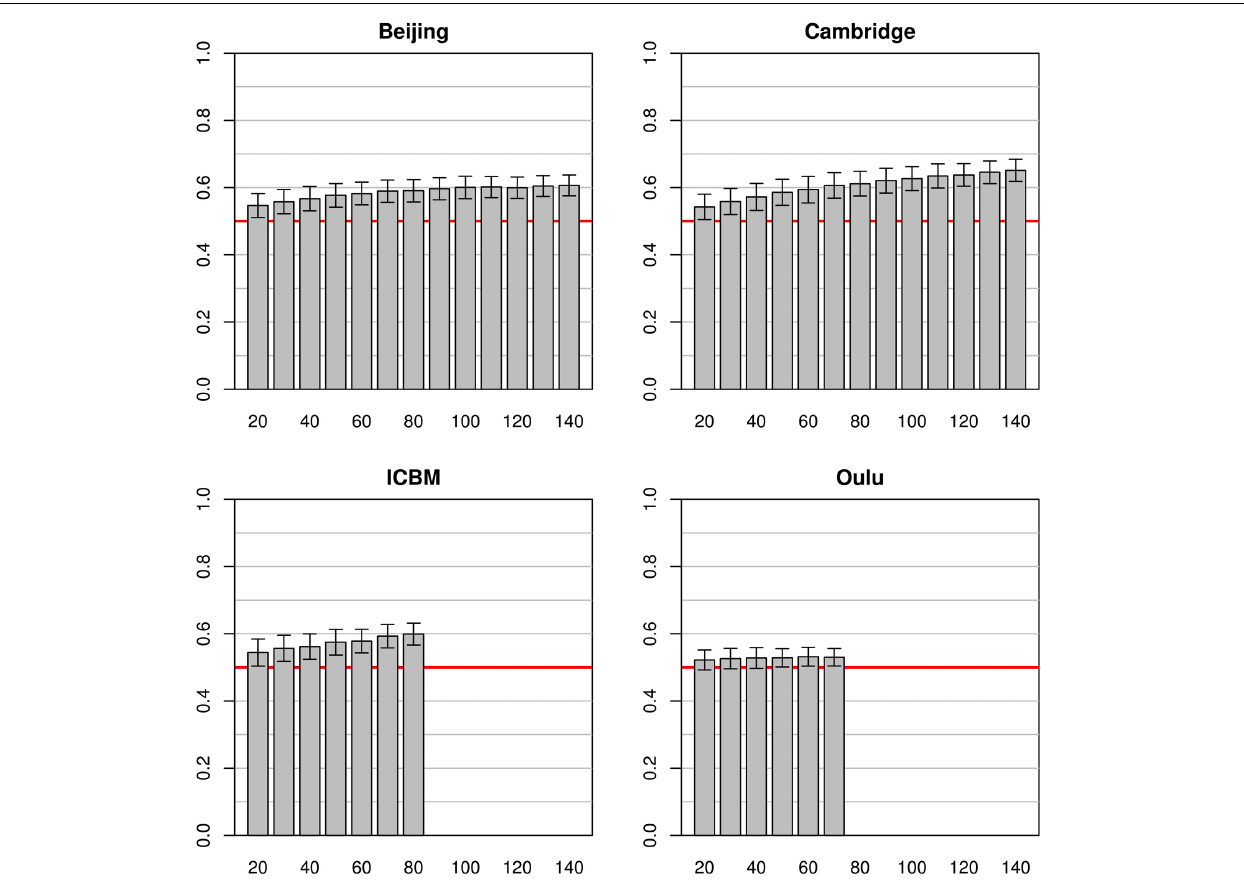
FIGURE 3 | Simulations using subjects from one study for the training datasets (with varying sample sizes) and 200 subjects from all other studies for the test datasets. The bars and whiskers represent means and